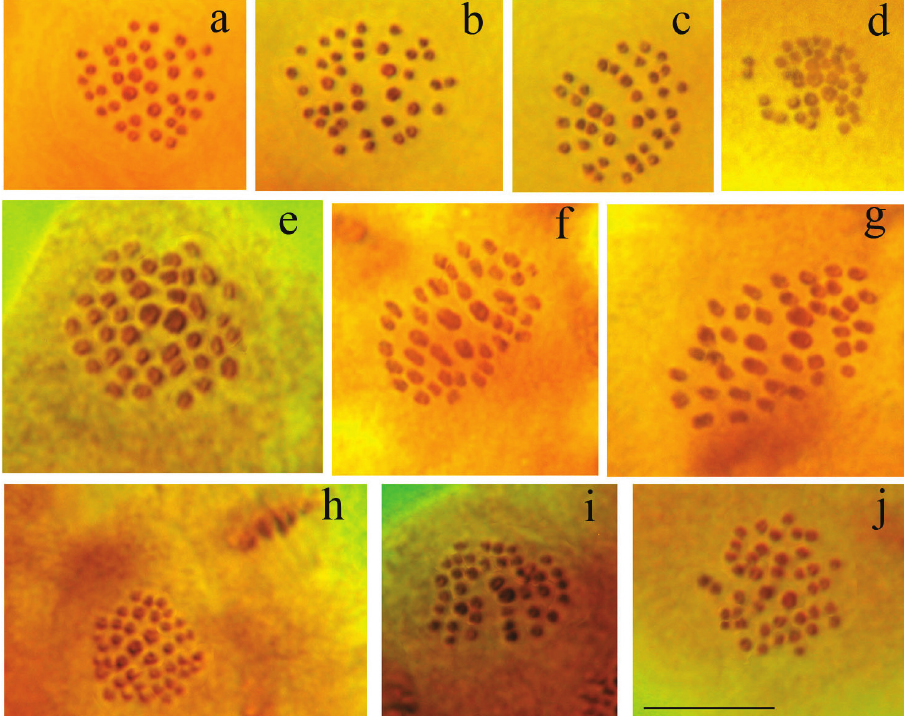
Figure 5. Polyommatus ( Agrodiaetus ) karyotypes. Bar = 10 µ. a P . timfristos , sample LR08D205, Cen- tral Greece, Parnassos, MII, n=38 b P . timfristos , sample LR08D205, Central Greece, Parnassos, MII, n=38 c P . timfristos , sample LR08D205, Central Greece, Parnassos, MII, n=38 d P . timfristos , sample LR08D258, Central Greece, Timfristos, MII, n=38 e P . orphicus eleniae , sample LR08D433, Northern Greece, MI, n=41 f P . orphicus eleniae , sample LR08D431, Northern Greece, MI, n=42 g P . orphicus eleniae , sample LR08D431, Northern Greece, MI, n=ca42 h P . orphicus eleniae , sample LR08D437, Northern Greece, MII, n=41 i P . orphicus eleniae , sample LR08D437, Northern Greece, MII, n=41 j P . orphicus eleniae , sample LR08D431, Northern Greece, MII,